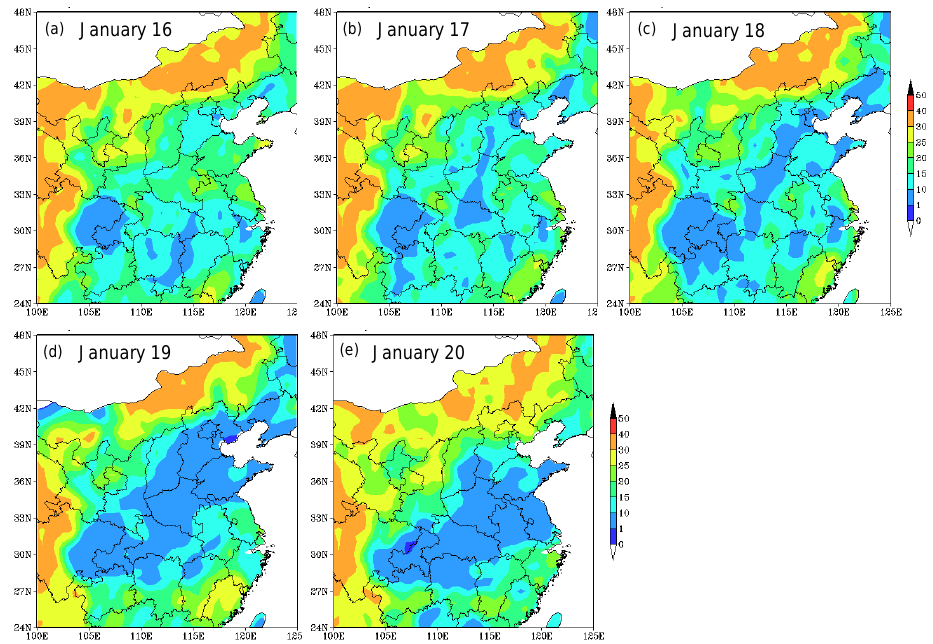
Fig.4. Regional distribution of visibility (km) at 14:00 (local time) during January 2 Fig. 4. Regional distribution of visibility (km) at 14:00 (LT) during 16–20 January.